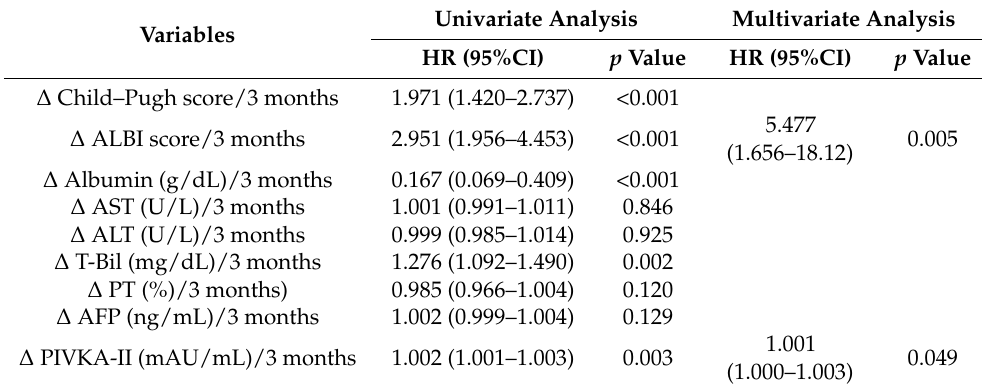
Table 5. Univariate and multivariate analyses of possible risk factors for overall survival among the changes of clinical indicators within 3 months by the Cox proportional hazards model. Univariate Analysis Multivariate Analysis Variables